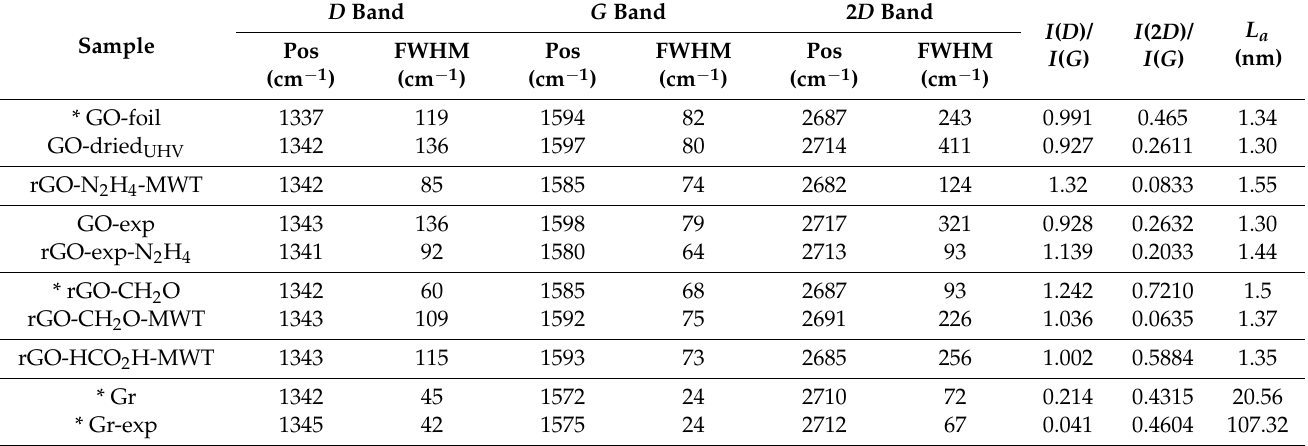
Figure 3. Raman spectra of: ( a ) GOs, rGO and graphites, ( b ) rGOs obtained using different reducing agents and microwave treatment (MWT). Table 2. The position, full-width at half maximum (FWHM) values and intensity ratios of D , G and 2 D modes of Raman spectra recorded from graphite, GOs and rGOs. and the effective crystallite size in direction of graphite plane ( L a